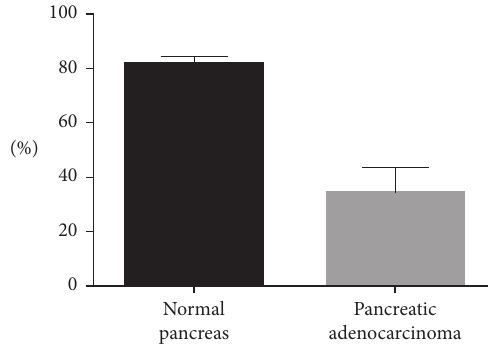
Figure 1: T-test data (mean with SEM). Table 1: Characteristics of healthy pancreas tissue donors and of patients with pancreatic adenocarcinoma. Normal pancreas